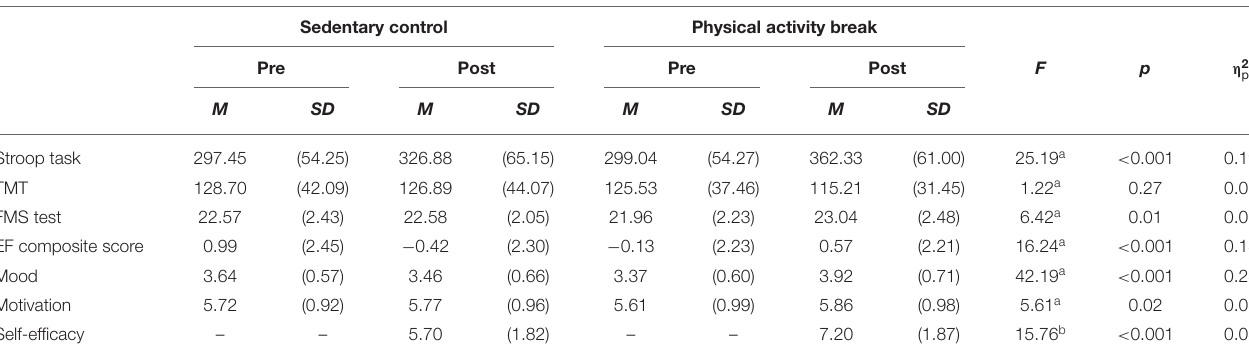
TABLE 2 | Executive functioning, mood, motivation, and task self-efficacy scores by group. Sedentary control Physical activity